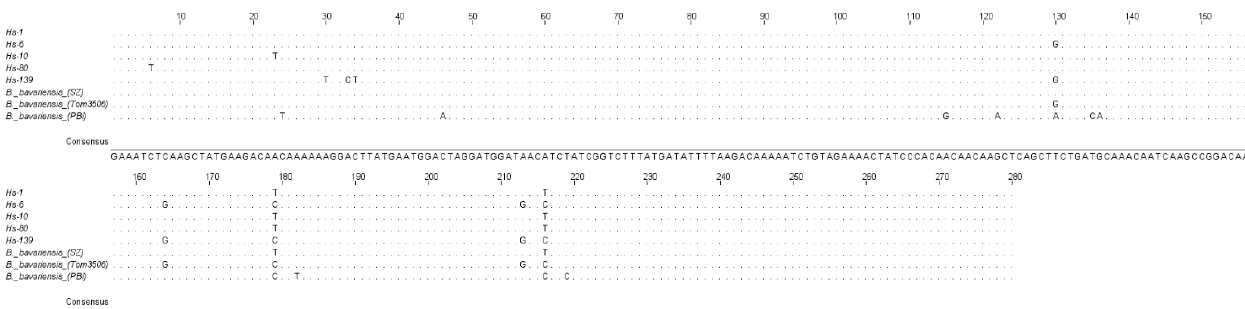
Figure 2. Nucleotide sequences of P66 gene loci of B. bavariensis in isolates with different al- lelic variants. The sequences were compared with other sequences of this gene taken from the GenBank